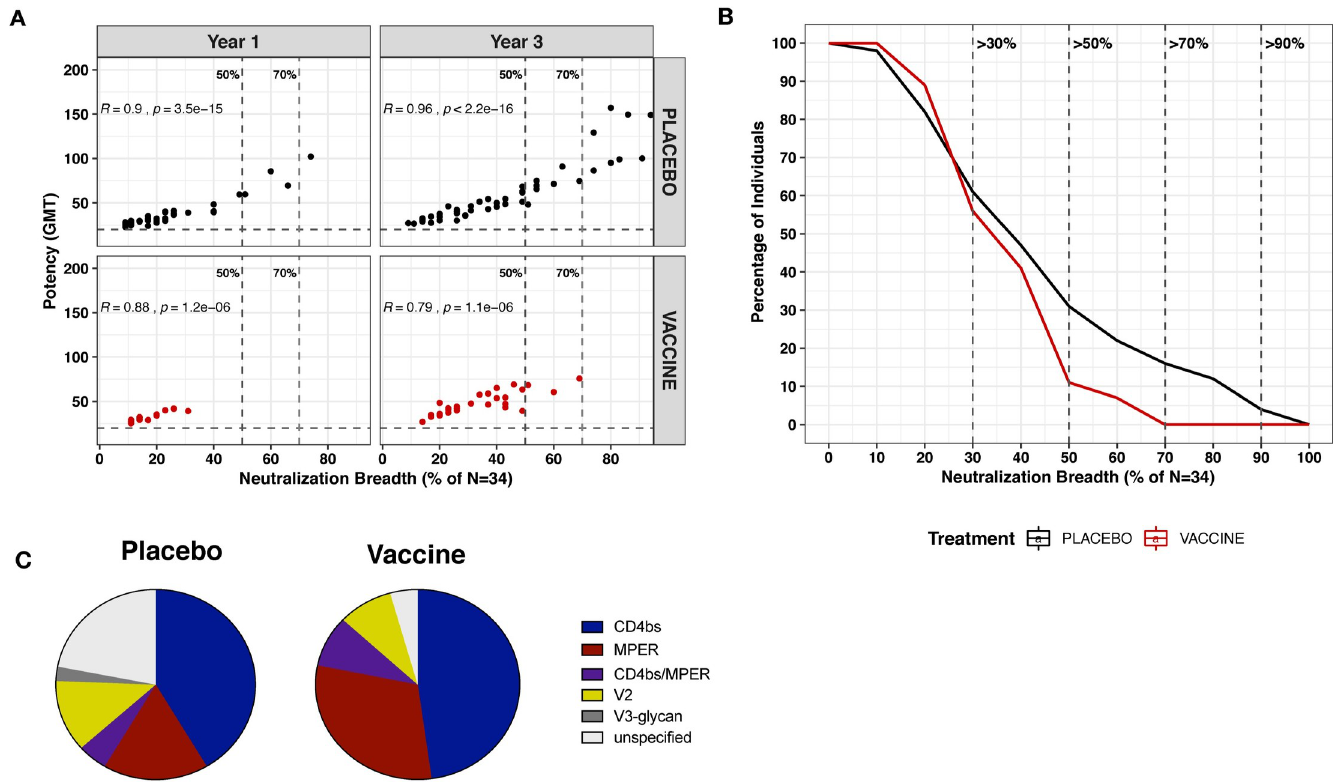
Fig 4. RV144 vaccination restricted the development of broadly neutralizing antibodies following HIV-1 infection. Vaccine recipients are represented in red and placebo recipients in black. (A) Neutralization breadth and potency (geometric mean titer (GMT)) of vaccine and placebo recipients at year 1 (N = 18 vaccine, 39 placebo) and year 3 (N = 27 vaccine, 49 placebo). Neutralization breadth is the percentage of viruses neutralized out of 34 pseudoviruses. Vertical lines indicate 50% and 70% neutralization breadth. (B) Reverse cumulative distribution curves showing the proportion of vaccine (N = 27) and placebo recipients (N = 49) who neutralized a specific fraction of the panel of 34 pseudoviruses at year 3 post-diagnosis. Only infected placebo recipients achieved > 70% neutralization breadth (N = 8) at year 3 post-diagnosis. (C) Predicted neutralization specificity of vaccine and placebo recipients with > 30% neutralization breadth.